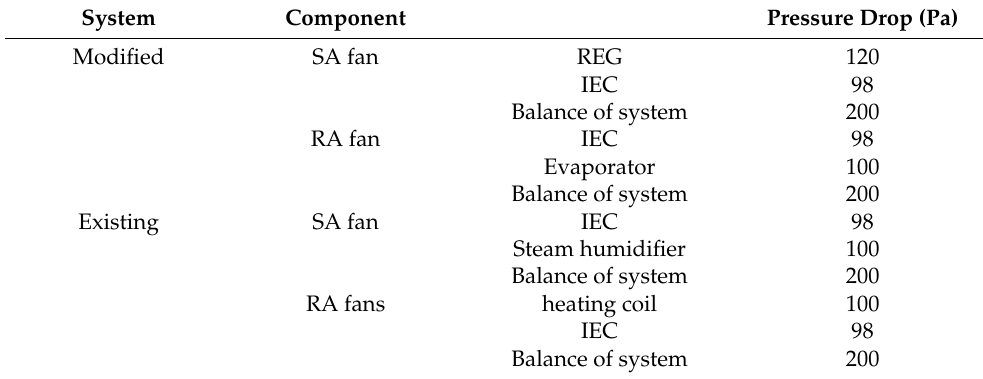
Table 7. Pressure drop value of each system